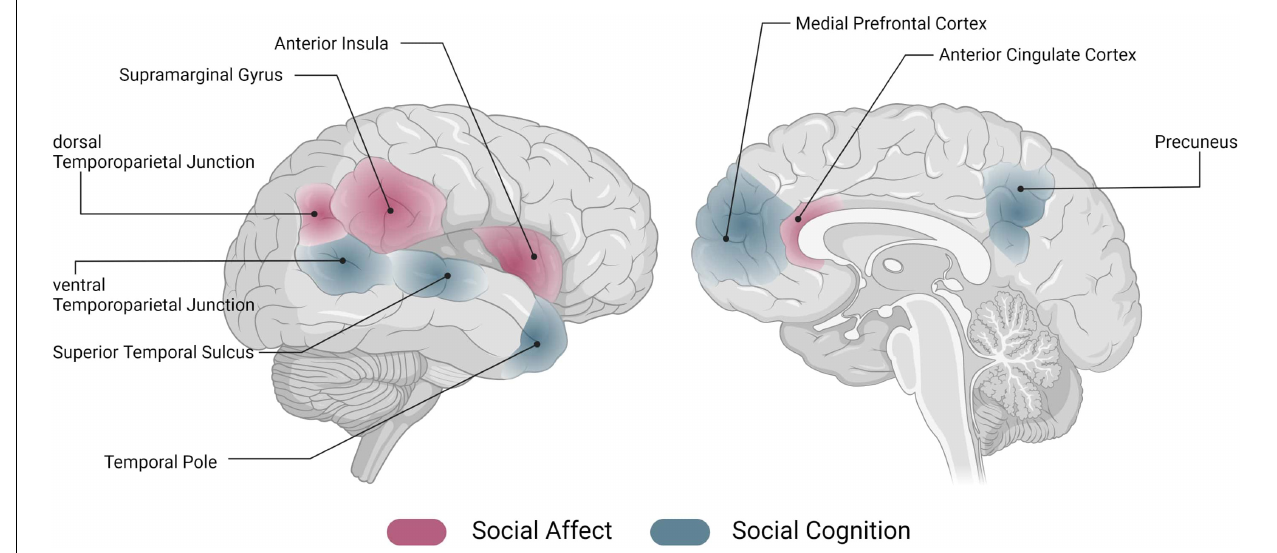
FIGURE 1 | Networks of the social brain. Schematic overview of activation in regions that have previously been associated with social affect (red) and social cognition (blue) [for an overview, see e.g., (7–10)]. Image generated using biorender